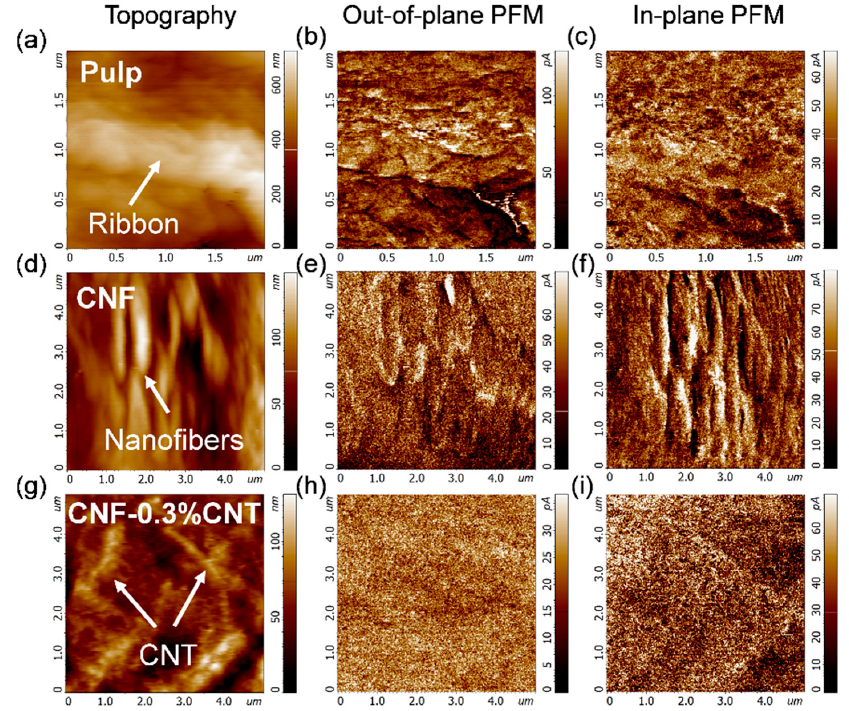
Figure 8. AFM images of the topography ( a , d , g ) as well as out-of-plane ( b , e , h ) and in-plane ( c , f , i ) PFM images of pulp fiber, CNF and CNF-0.3%CNT samples, respectively.